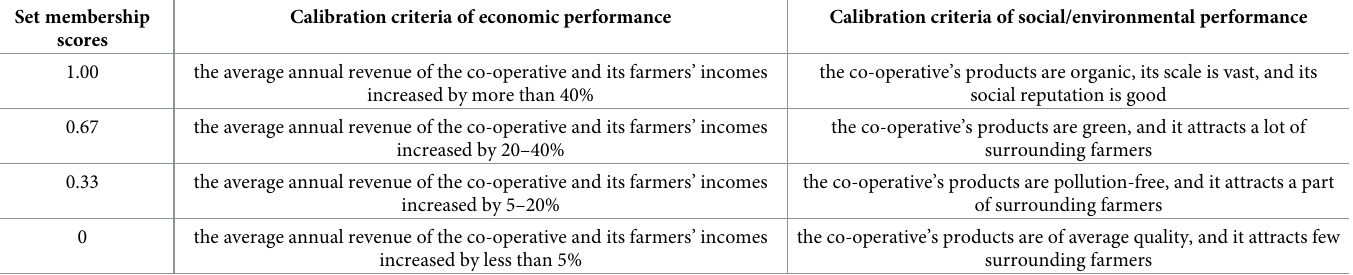
Table 1. Calibration criteria of the outcome